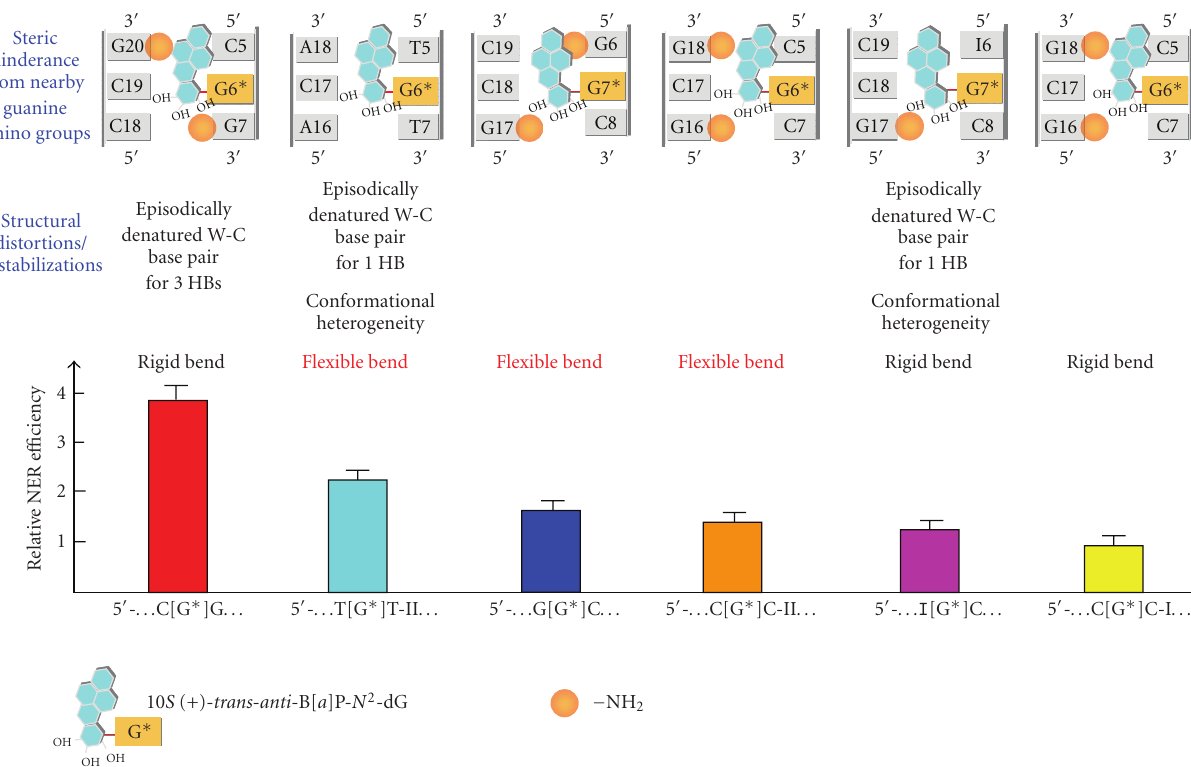
Figure 4: Hierarchy of NER recognition signals for the 10 S (+)- trans - anti -B[ a ]P- N 2 -dG adduct in various sequence contexts.